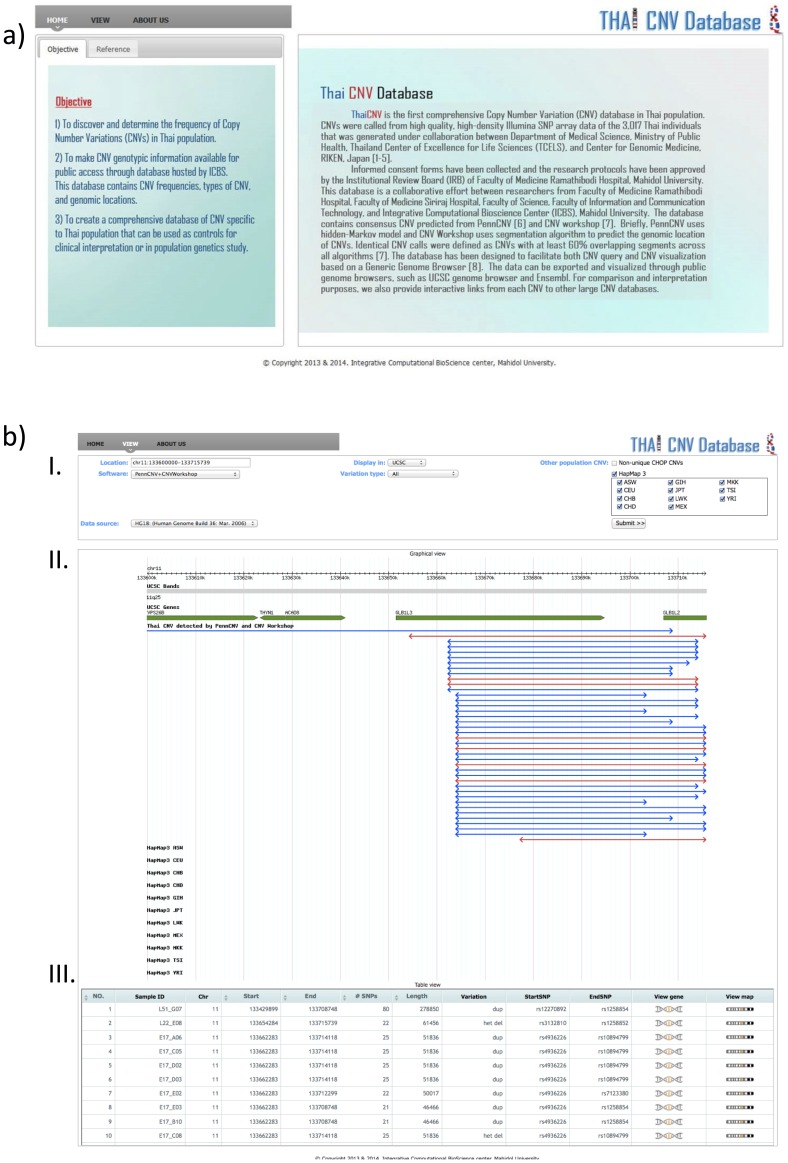
Thai CNV database.a) A screen-captured image of Thai CNV homepage (http://thaicnv.icbs.mahidol.ac.th/thaicnv/); b) An example of CNV search page. Red and blue lines indicate deletion and duplication CNVs, respectively. Arrowheads indicate the starting and ending genomic locations. Panel I - input panel; panel II - graphical view; panel III - table view.